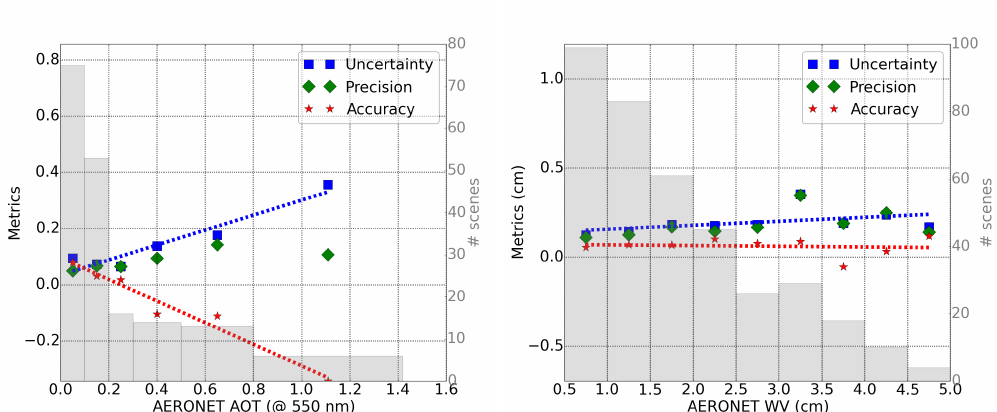
Figure 4. Accuracy (red star), precision (green diamond) and uncertainty (blue square) for calculated AOT ( left ) and WV ( right ) for Sentinel-2 as a function of the reference values (AERONET). The number of scenes included in each bin are shown in the shadow histogram and in the right axis. The accuracy and uncertainty fits are displayed as dotted red and blue lines, respectively. Table 3. Distribution results (A, P, and U) for the aerosol optical thickness (AOT) and water vapor column (WV) for Sentinel-2 and Landsat-8 with respect to AERONET data. The number of scenes (N) and the mean and median value of each distribution have been included. AOT 550 WV [cm] Satellite N